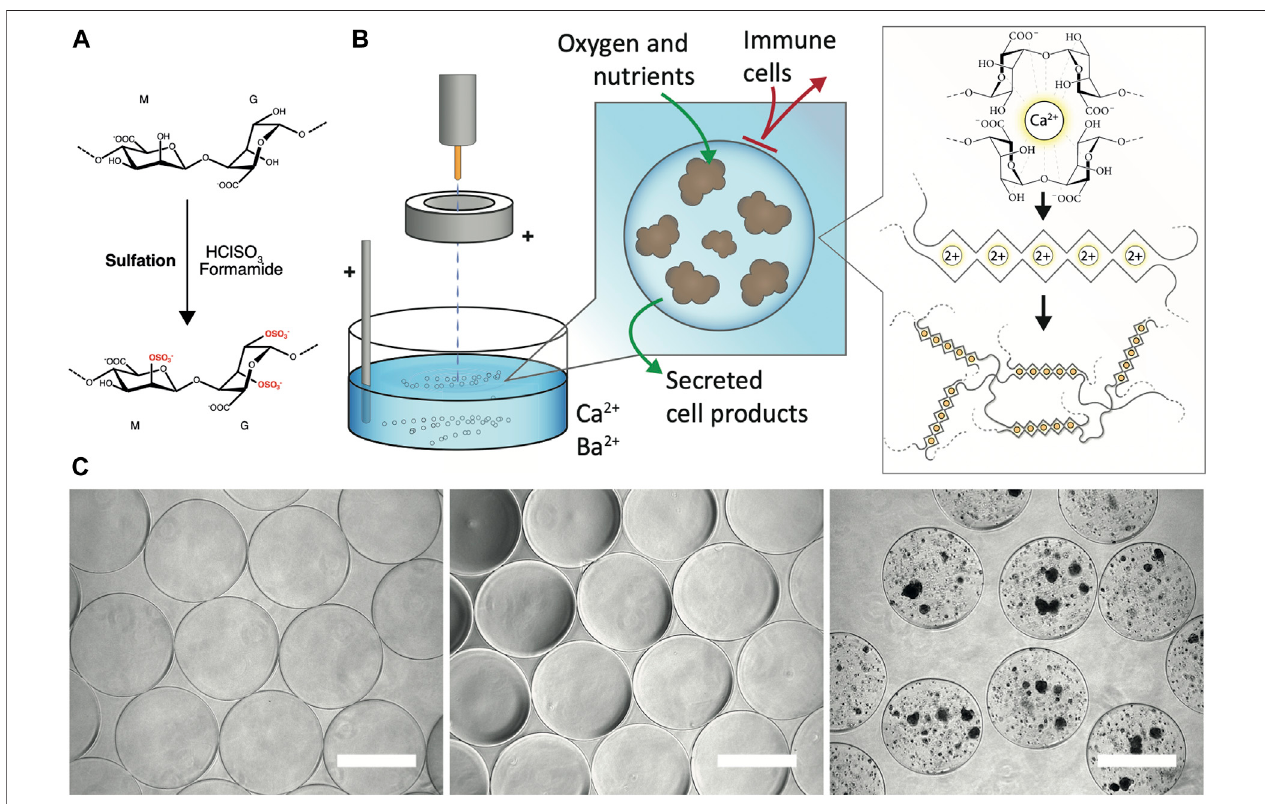
FIGURE 1 | Generation of sulfated alginate and alginate microbeads. (A) Sulfation of the alginate by treatment with chlorosulfonic acid in formamide (B) Encapsulation of PSC-Hep spheroids. The spheroids in a homogenous mixture of calcium-free alginate solution are pumped out of the encapsulator nozzle. The electrostaticacceleratorringpullsthedropletsdownwardsresultinginasmallerdropletdiameter.Subsequently, thecell-alginatedropletsarecollectedinbivalentcation (Ca 2+ and Ba 2+ ; shown as 2+ )-containing solution which promotes crosslinking of predominantly the blocks of L-guluronic acid in the alginate, and generation of solid-phasealginatebeads.Thealginatematrixallowsdiffusionofoxygen,nutrientsandsecretedcellproducts,andprovidesabarrieragainstin fi ltrationofimmunecells. (C) Gross morphology ofalginate microbeadsby bright fi eld microscopy. Unmodi fi edUP-LVG alginate microbeads (left), 40% sulfated alginate microbeads (middle) and hPSC-Heps spheroids encapsulated in 40% sulfated alginate (right) all showed regular morphology. Scale bars: 500 μ